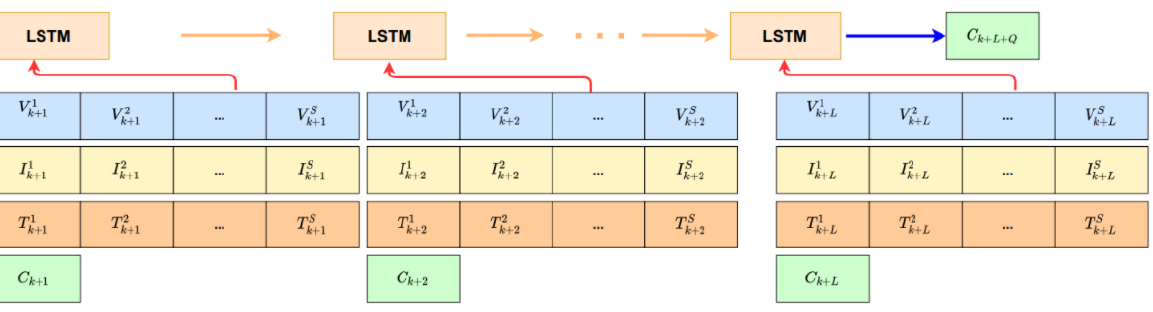
Figure 7. Encoding channel-wise data in Multi-channel SoH estimation